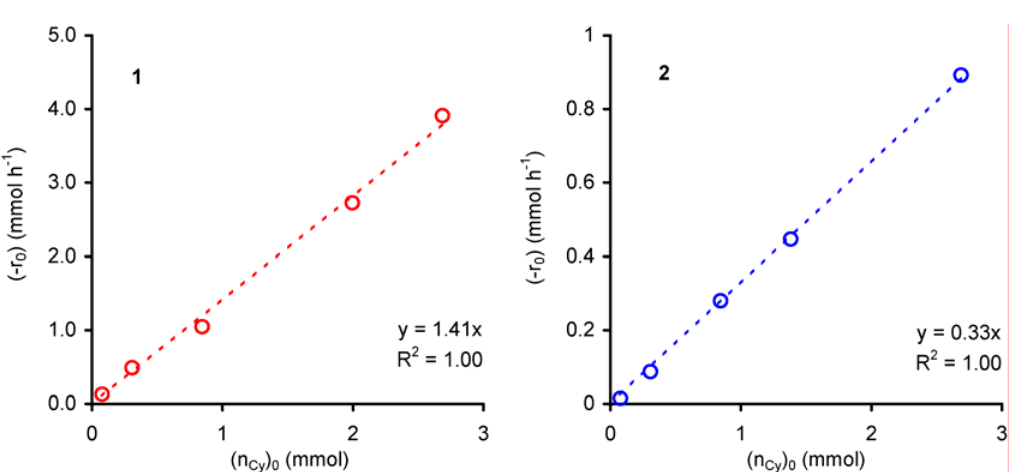
Figure 4. Dependence of the initial rate of cyclooctene epoxidation (with t- BuOOH in decane), catalysed by compounds 1 or 2 , as a function of the initial charge of cyclooctene.